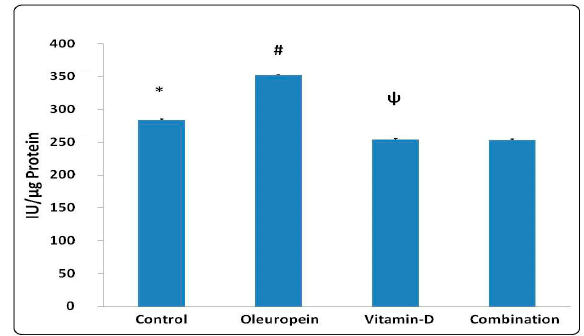
Figure 4. Glutathione peroxidase analysis results. # Oleuropein treatment has significantly increased GPx as compared to vitamin D and combination treatment.